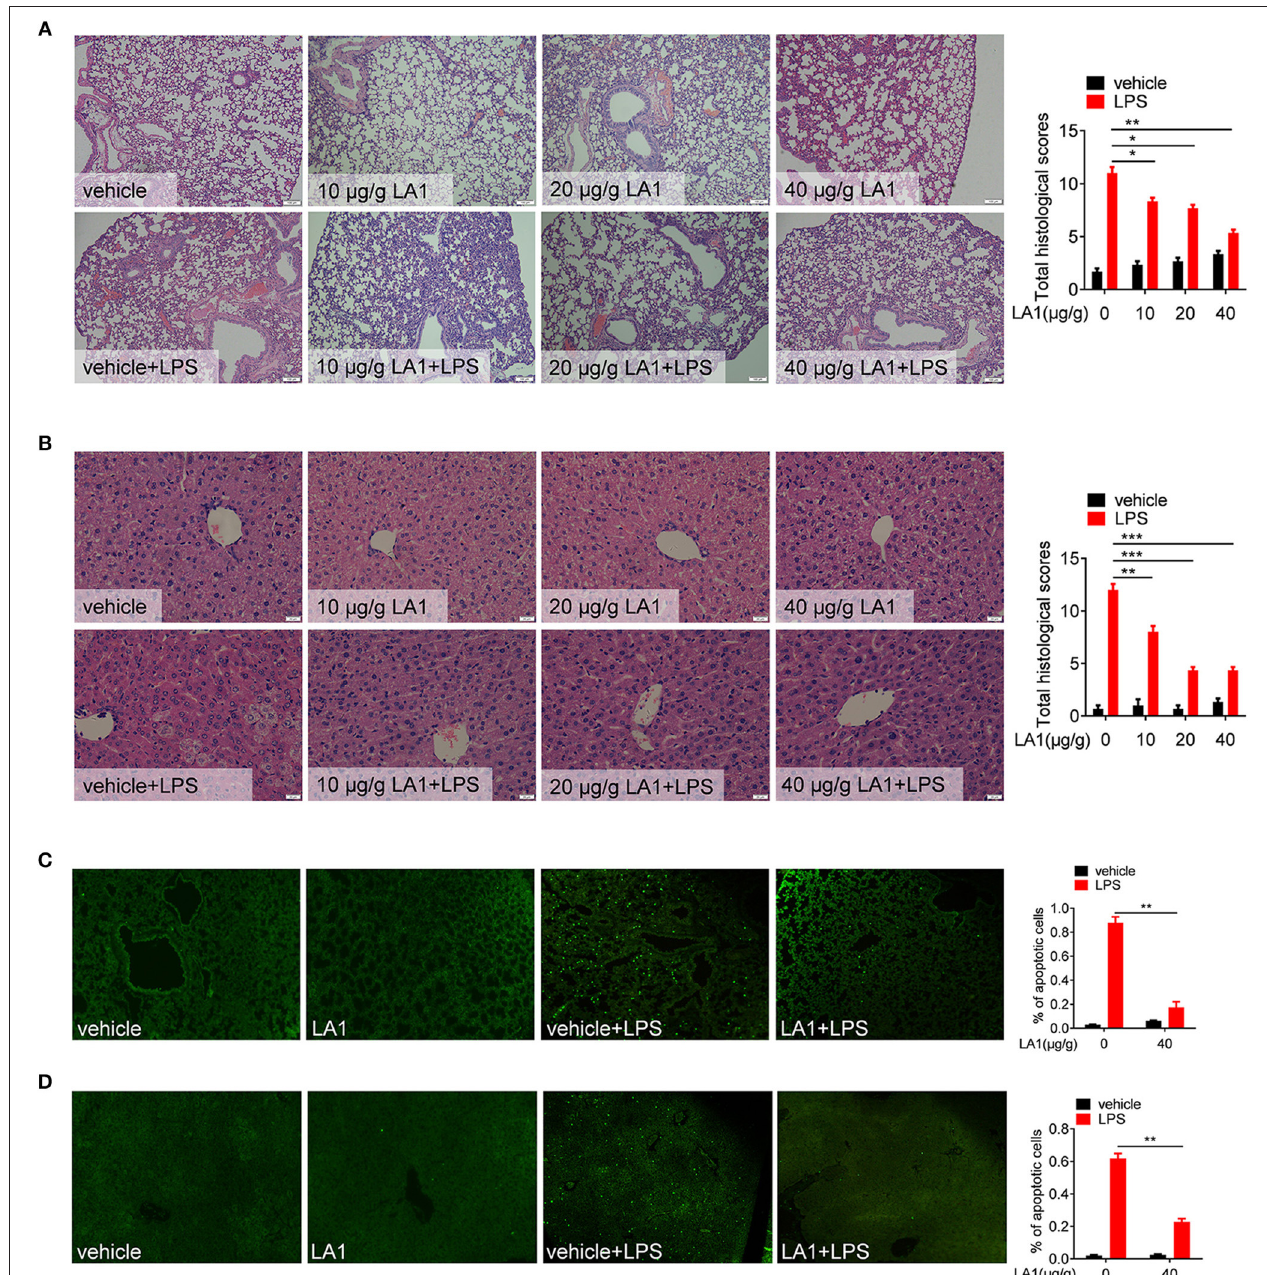
FIGURE 2 | Activation of CD11b by LA1 alleviated LPS-induced lung and liver injury. (A, B) C57BL/6 mice were treated with either LA1 (10, 20, and 40 µ g/g of body weight) or vehicle for 2h, and then, stimulated with LPS (10 µ g/g of body weight). After 12h, tissues of lung and liver were fixed with 4% paraformaldehyde and paraffin-embedded lung (A) and liver (B) sections were stained with H&E. (C, D) C57BL/6 mice were treated with either LA1 (40 µ g/g of body weight) or vehicle for 2h, and then, stimulated with LPS (10 µ g/g of body weight). After 12h, apoptosis in the cells of lung (C) and liver (D) was analyzed by TUNEL. Data shown are representative of three independent experiments. Error bars represent S.E.M. * p < 0.05, ** p < 0.01, *** p < 0.001, as determined by two-way ANOVA post-hoc Bonferroni Multiple Comparison Test.